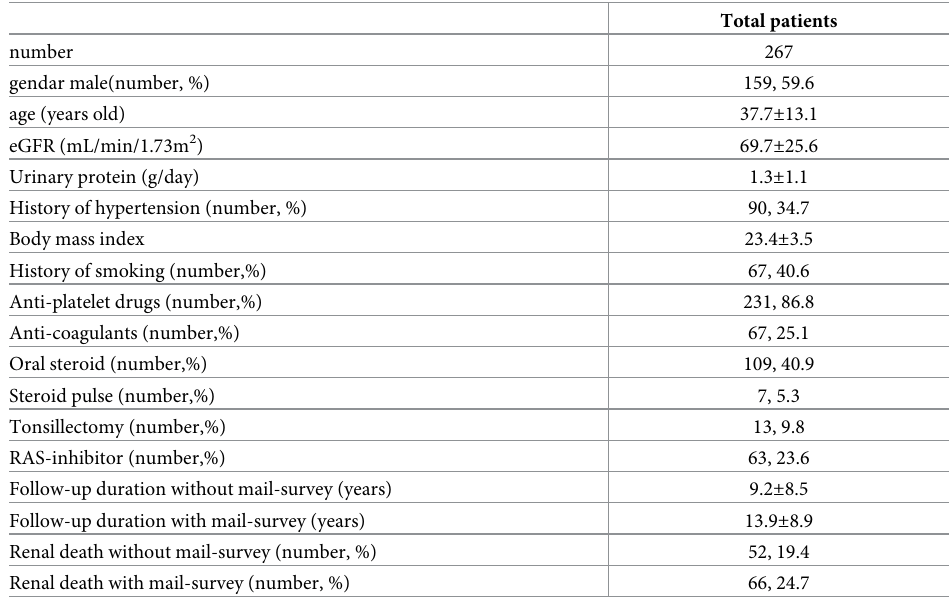
Table 1. Clinical characteristics of